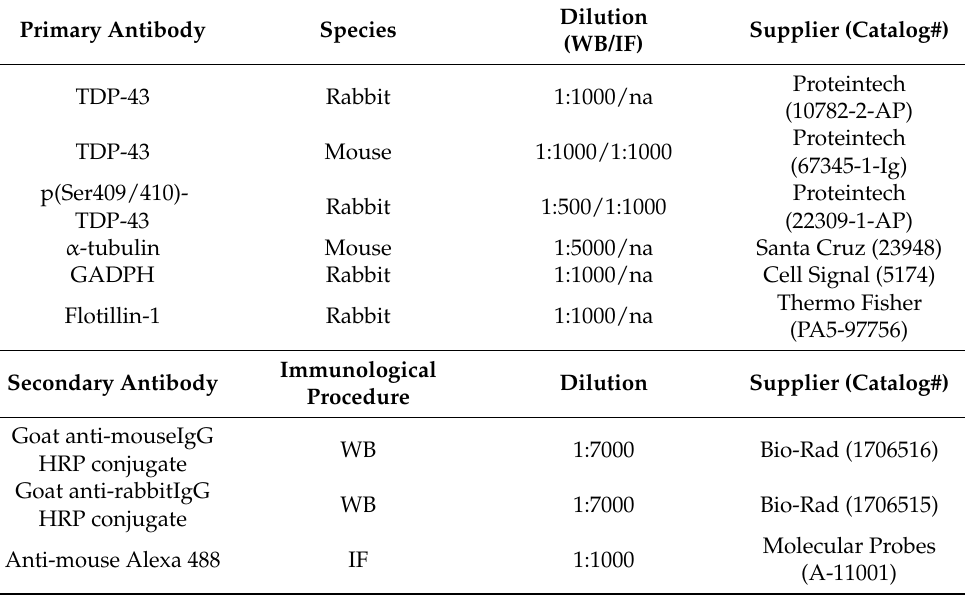
Table 1. Primary and secondary antibodies used in the